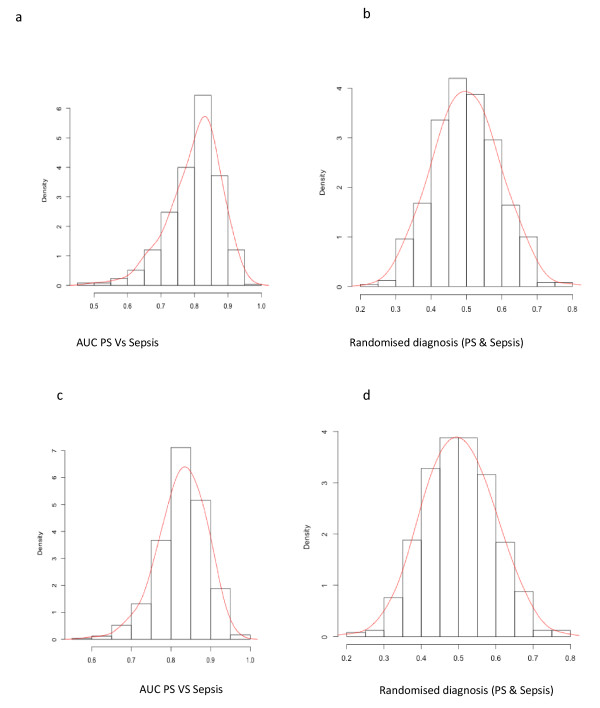
AUC ROC permutation comparisons and distribution graphs between PS and Sepsis cohorts. Permutation analyses were conducted using 500 iterations, where the data was randomly split into training and validation sets to evaluate diagnostic performance. Average AUC ROC for gene sets of 42 and 7 were determined to be 0.92 ± 0.0586 and 0.862 ± 0.0640, respectively. When labels associated with cohort status were removed, the AUC distribution was on average 0.498 indicating that there was no inherent bias in this methodology.